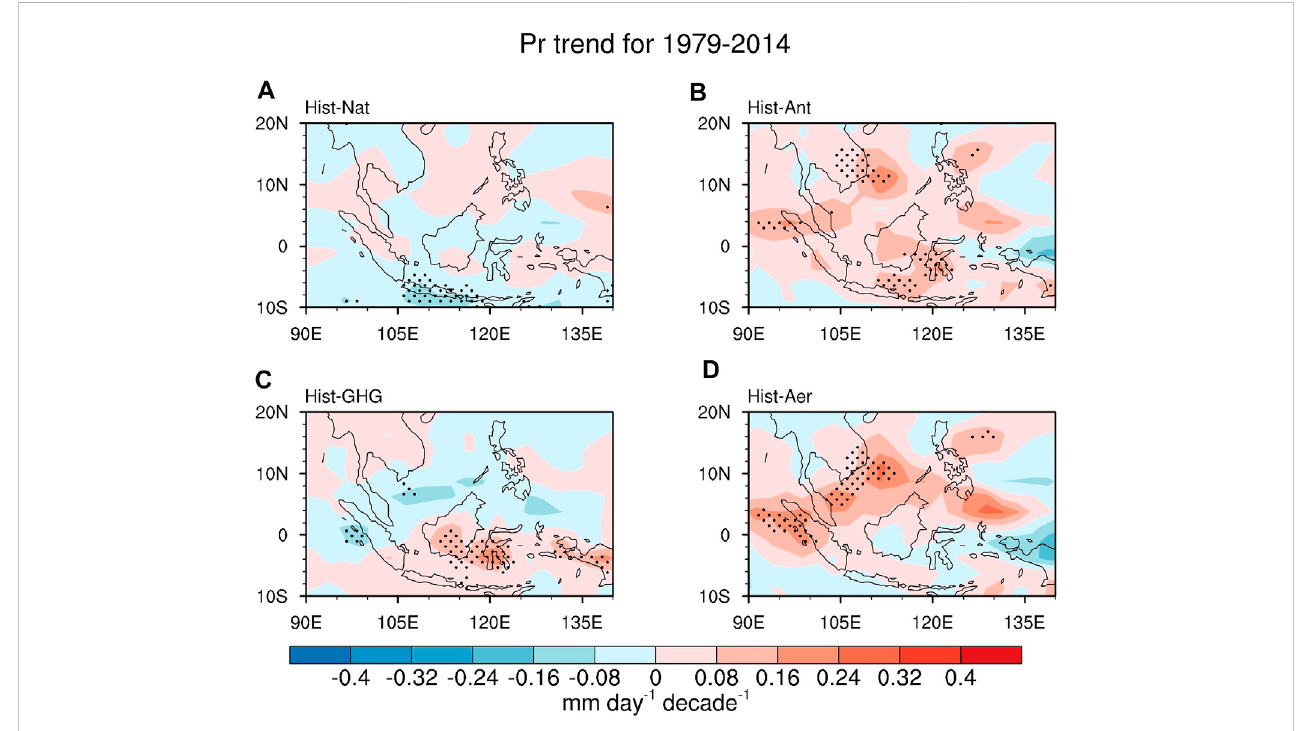
FIGURE 3 Same as Figure 2C, but for (A) Hist-Nat, (B) Hist-Ant, (C) Hist-GHG, and (D) Hist-Aer MME, respectively.